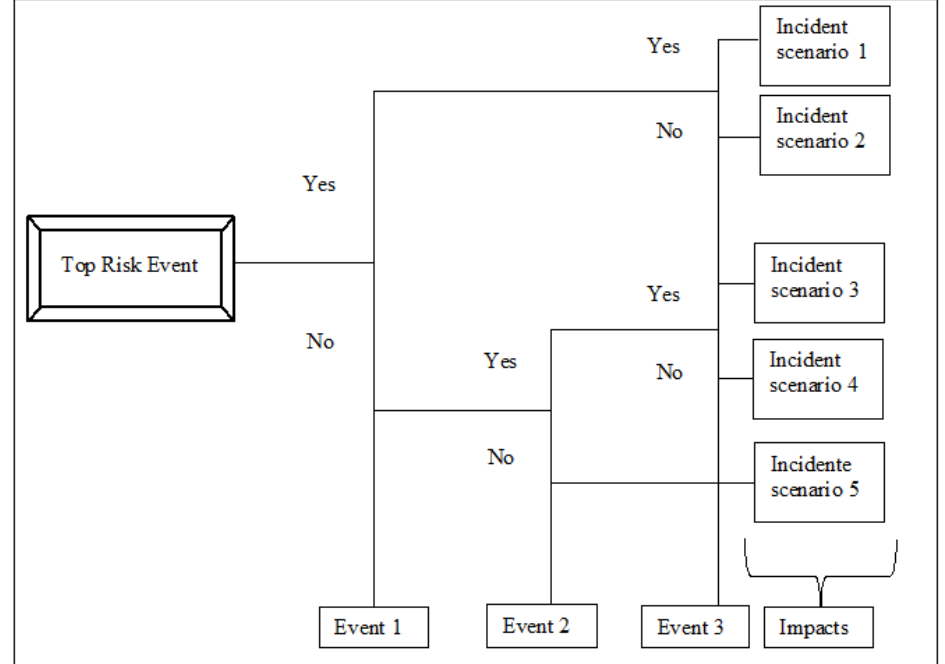
Figure 3. General event tree.